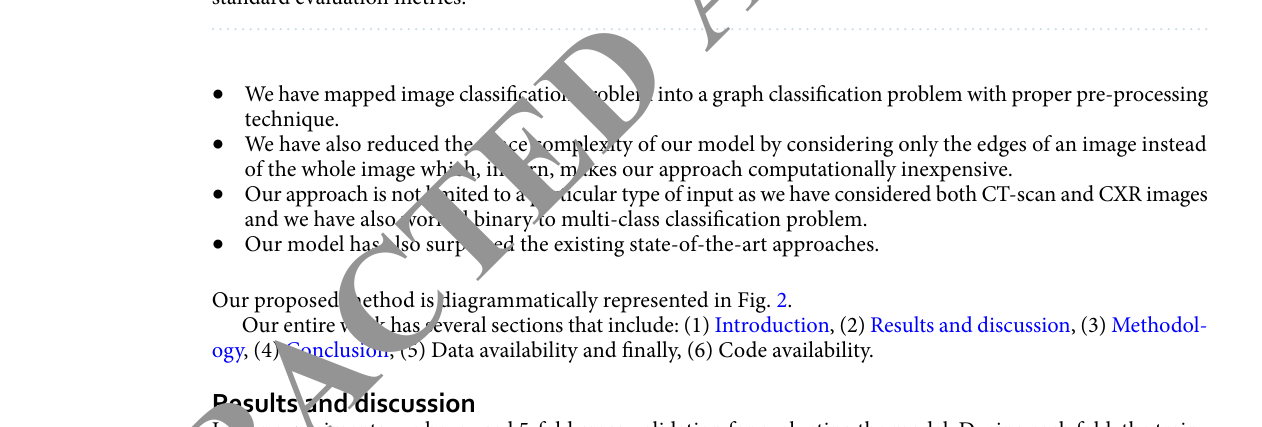
Table 1. Detailed results of the proposed GraphCovidNet model for all the four datasets in terms of some standard evaluation metrics.